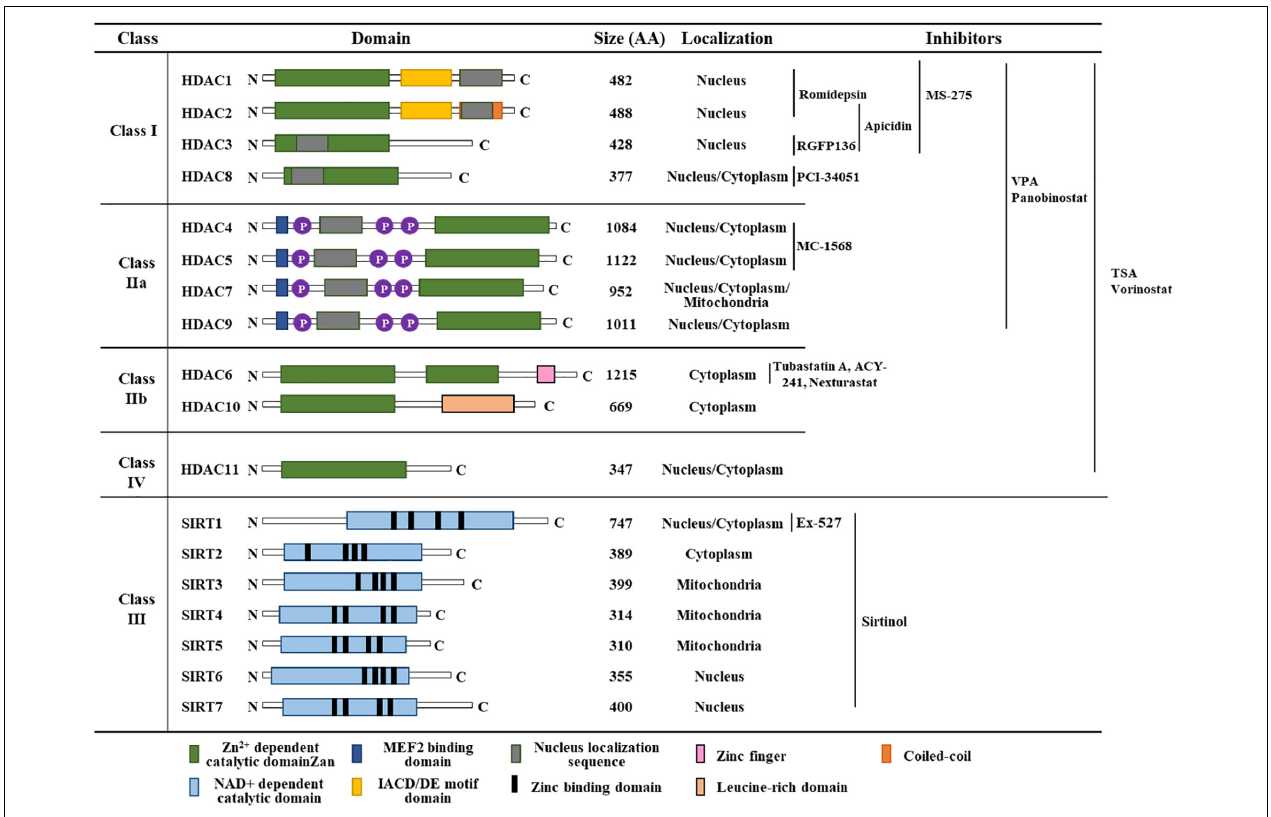
FIGURE 2 | Classification of HDACs, functional domains, and HDAC inhibitors. TSA denotes trichostatin A. AA denotes amino